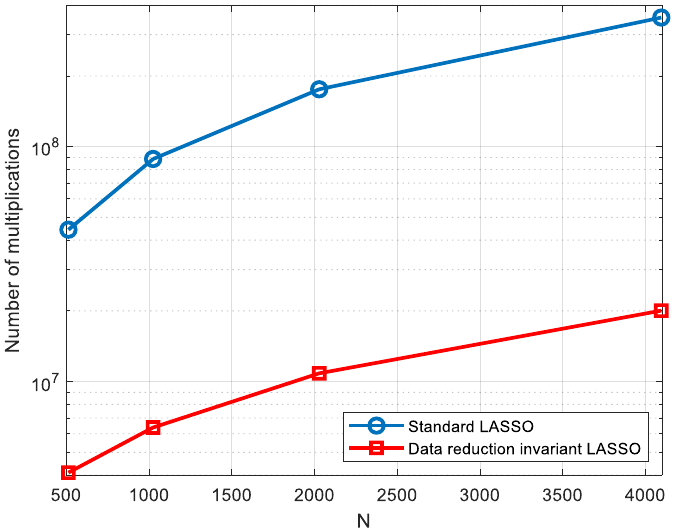
Figure 4. Complexity gain comparison in terms of number of multiplications.